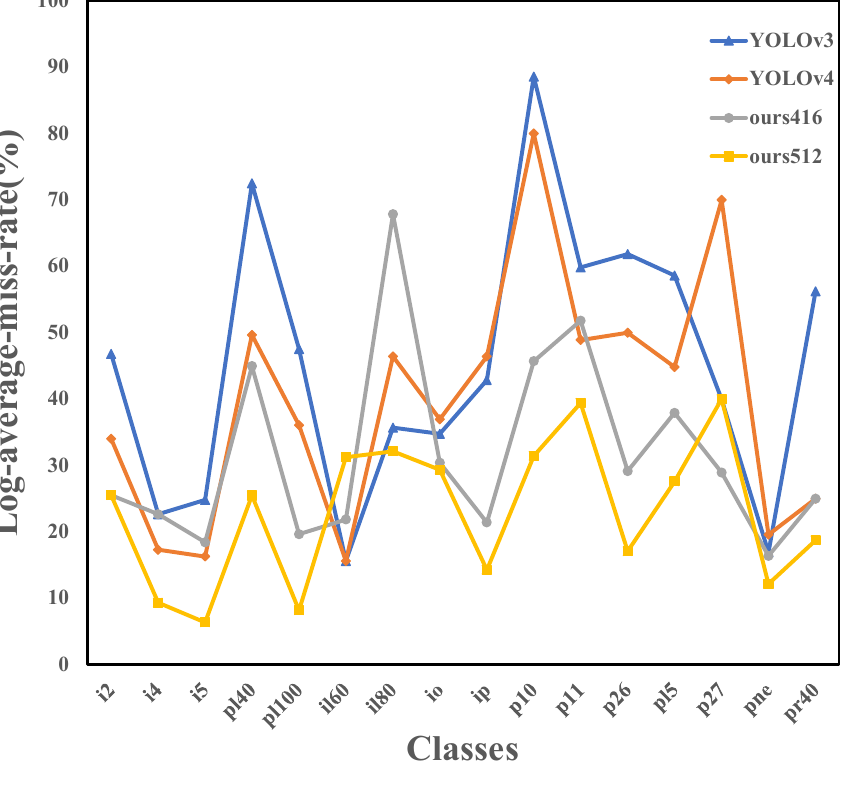
Figure 6. Comparison of miss